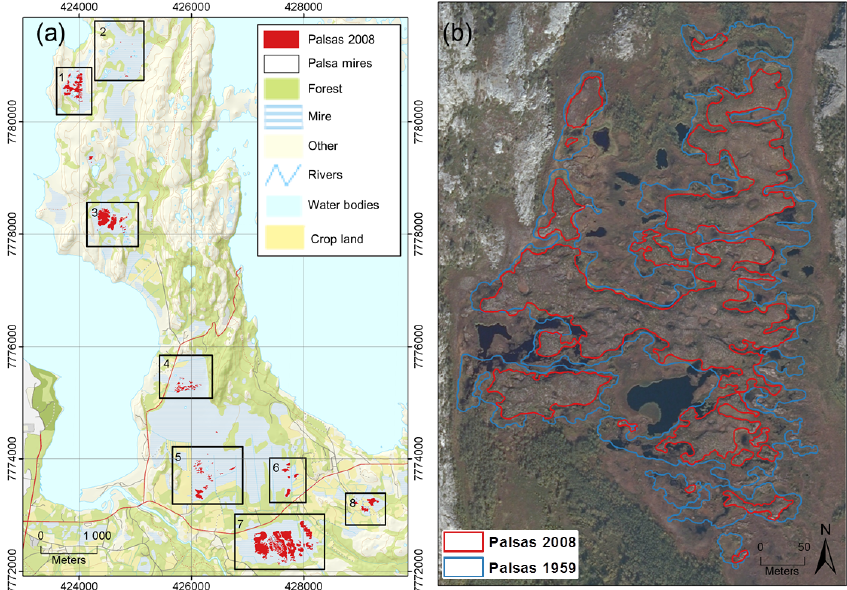
Figure 7. (a) Palsa mires mapped in the study area Lakselv. Some smaller palsas are outside these eight palsa mires. Background map from Kartverket (2015b) with projection in UTM 35N. (b) Palsas mapped in palsa mire 1 in Lakselv. Background image from 2008 through Norgeibilder (2015).